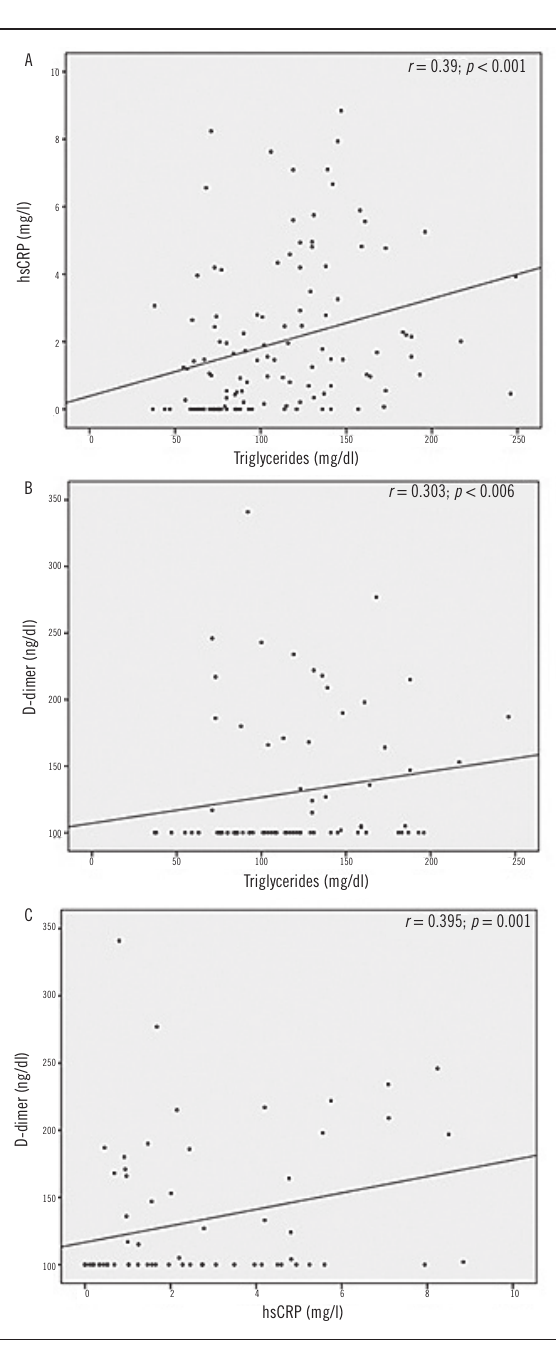
figurE − Correlation between: A) triglycerides and hsCRP; B) triglycerides and D-dimer; C) D-dimer and hsCRP hsCRP: high-sensitivity C-reactive